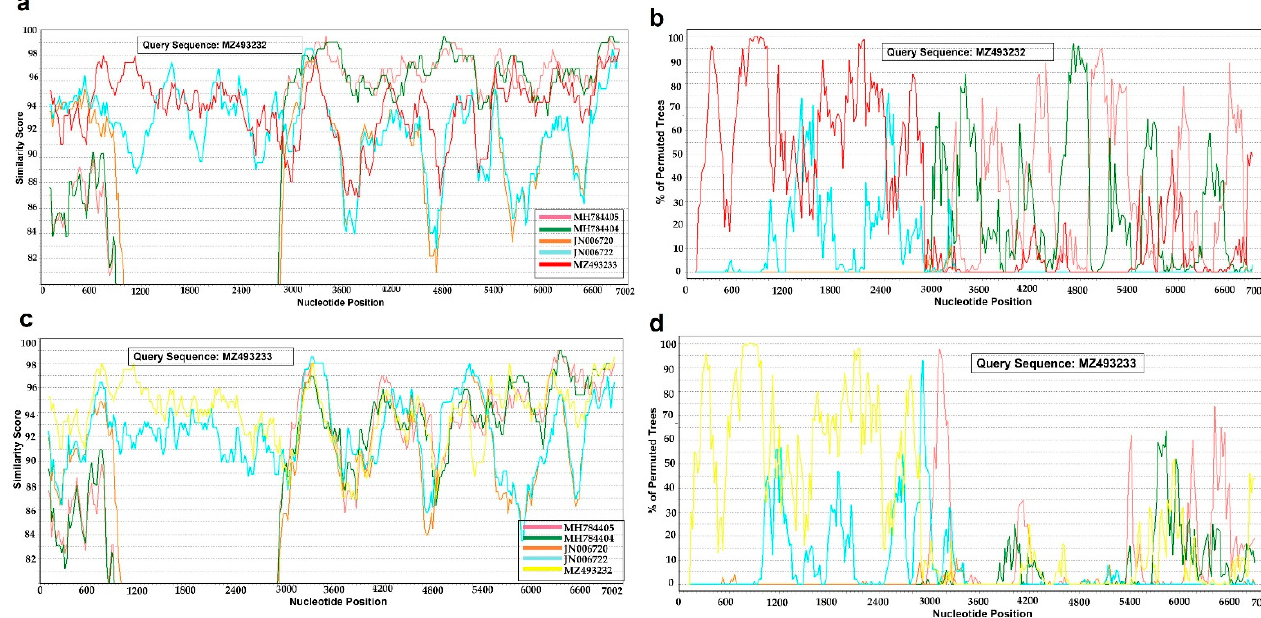
Figure 3. Recombination analysis of A/ASIA/Iran-05/SIS-13 isolates with most closely related isolates for serotype A, O, and Asia 1. Similarity plots were generated for query sequences ( a ) A_PK_C6_2017 and ( c ) A_PK_C8_2018. The nucleotide positions are drawn across the x-axis, while nucleotide similarity (percentage) is plotted along the y-axis. Breakpoints exist where sequences cross over each other. The figures show regions with more than 80% sequence similarity. The similarity was further tested by the permutation of trees with BootScan; plots ( b , d ) were generated with 1000 bootstrap for 100 permutation trees. The x-axis represents nucleotide positions, while the y-axis shows the percentage of permuted trees where selected sequences were closely related to the query. The threshold of the indication of a potential recombination event was set at 70%.